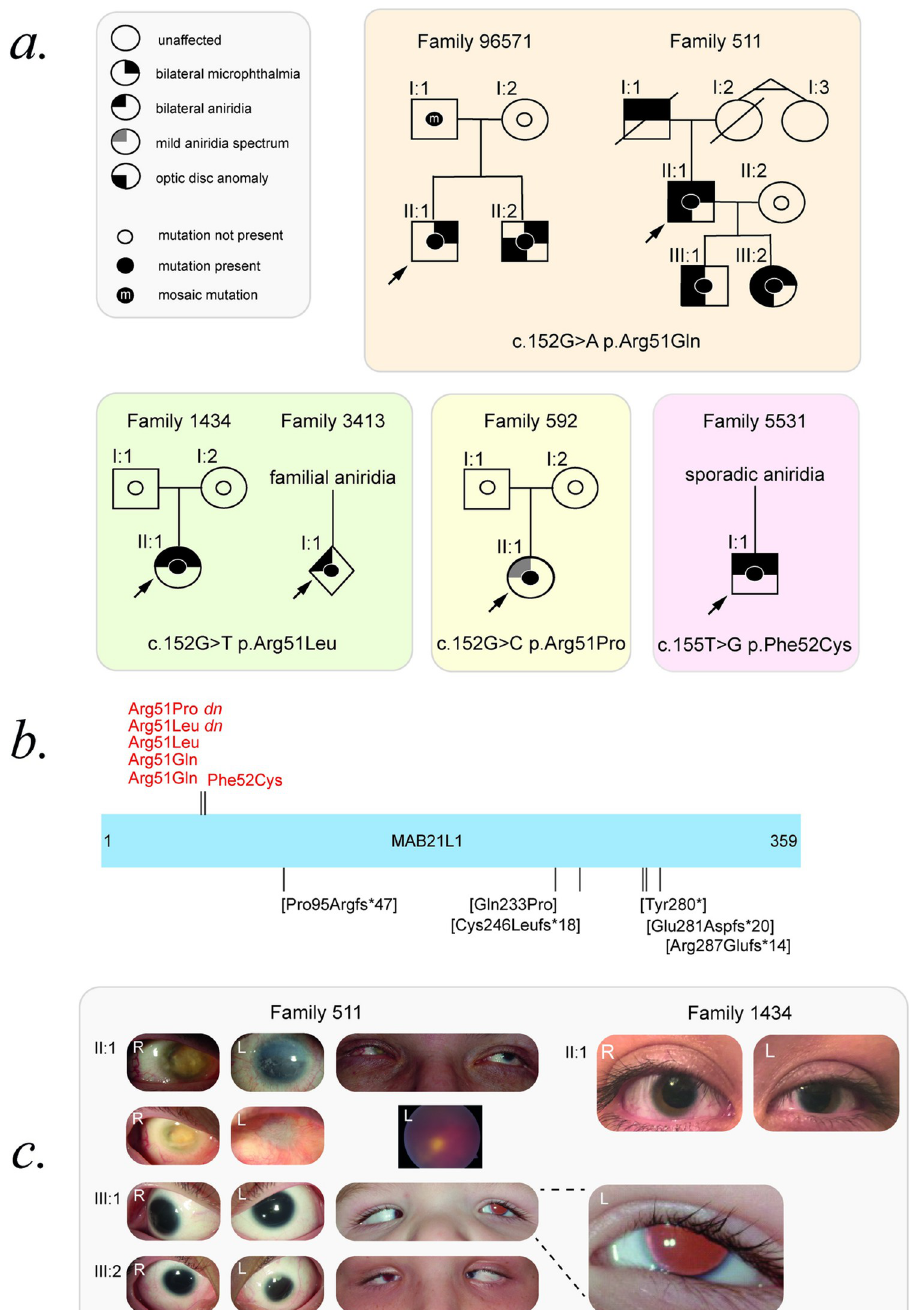
Fig 1. MAB21L1 Arg51 and Phe52 substitution causes microphthalmia and aniridia. A . Pedigrees are shown for the six families with MAB21L1 variants and bilateral microphthalmia and/or aniridia. The pedigrees are ordered by variant: c.152G > A p.(Arg51Gln) (orange shaded box), c.152G > T p.(Arg51Leu) (green shaded box), c.152G > C p. (Arg51Pro) (yellow shaded box) and c.155T > G p.(Arg52Cys) (pink shaded box). A key to the pedigree symbols is shown to the left (grey shaded box). B . A schematic of MAB21L1 represented as a linear bar and with the first and last amino acid residue numbered. The linear positions of all pathogenic variants are shown: The monoallelic variants in this study are detailed above (red text) and the published biallelic variants are detailed below (bracketed black text). C . Clinical images of individuals with MAB21L1 Arg51-related eye malformations. R, right eye; L, left eye. Family 511 all have profound aniridia, microcornea, choroidal coloboma (just visible in II:1’s L fundus photo) and optic disc anomalies. The progression of disease in II:1 over one decade is shown between with the upper and lower photos,